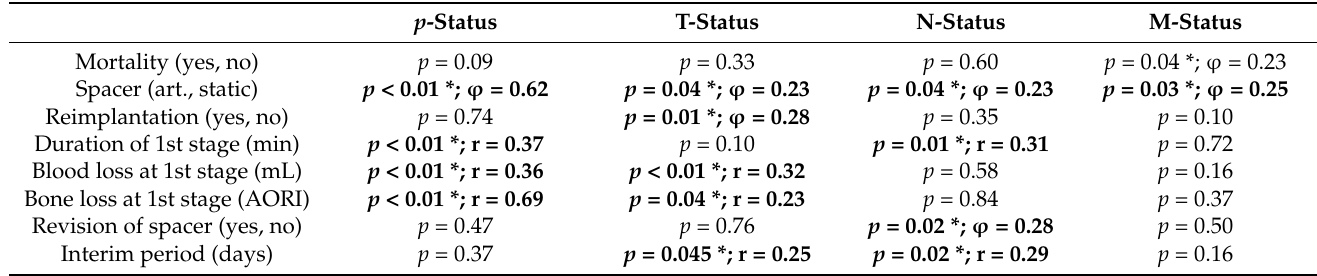
Table 4. The “modified PJI-pTNM classification” and therapy/outcome parameters were analyzed for correlations by conducting the Spearman’s rank correlation and chi-square test. Level of significance was set at p < 0.05 and, if achieved, is written in bold letters and marked with an asterisk (*). In case of a statistically significant correlation, the effect size was calculated by determining Spear- man ’ s rho (r), phi- coefficient (φ) , or Cramér’s V (V). The effect size is class ified as small (0.1), me- dium (0.3), or large (0.5).